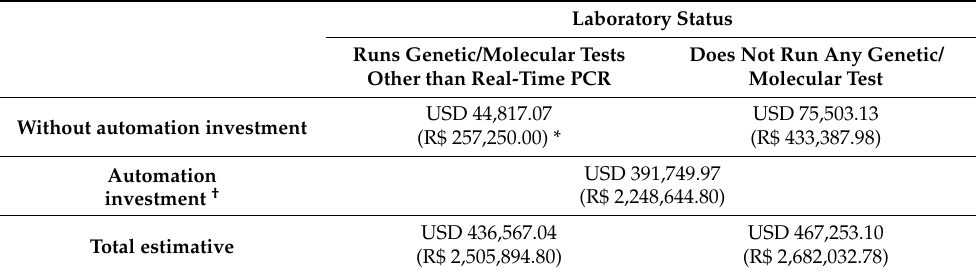
Table 2. Estimated costs for the equipment acquisition depending on the previous infrastructure of the